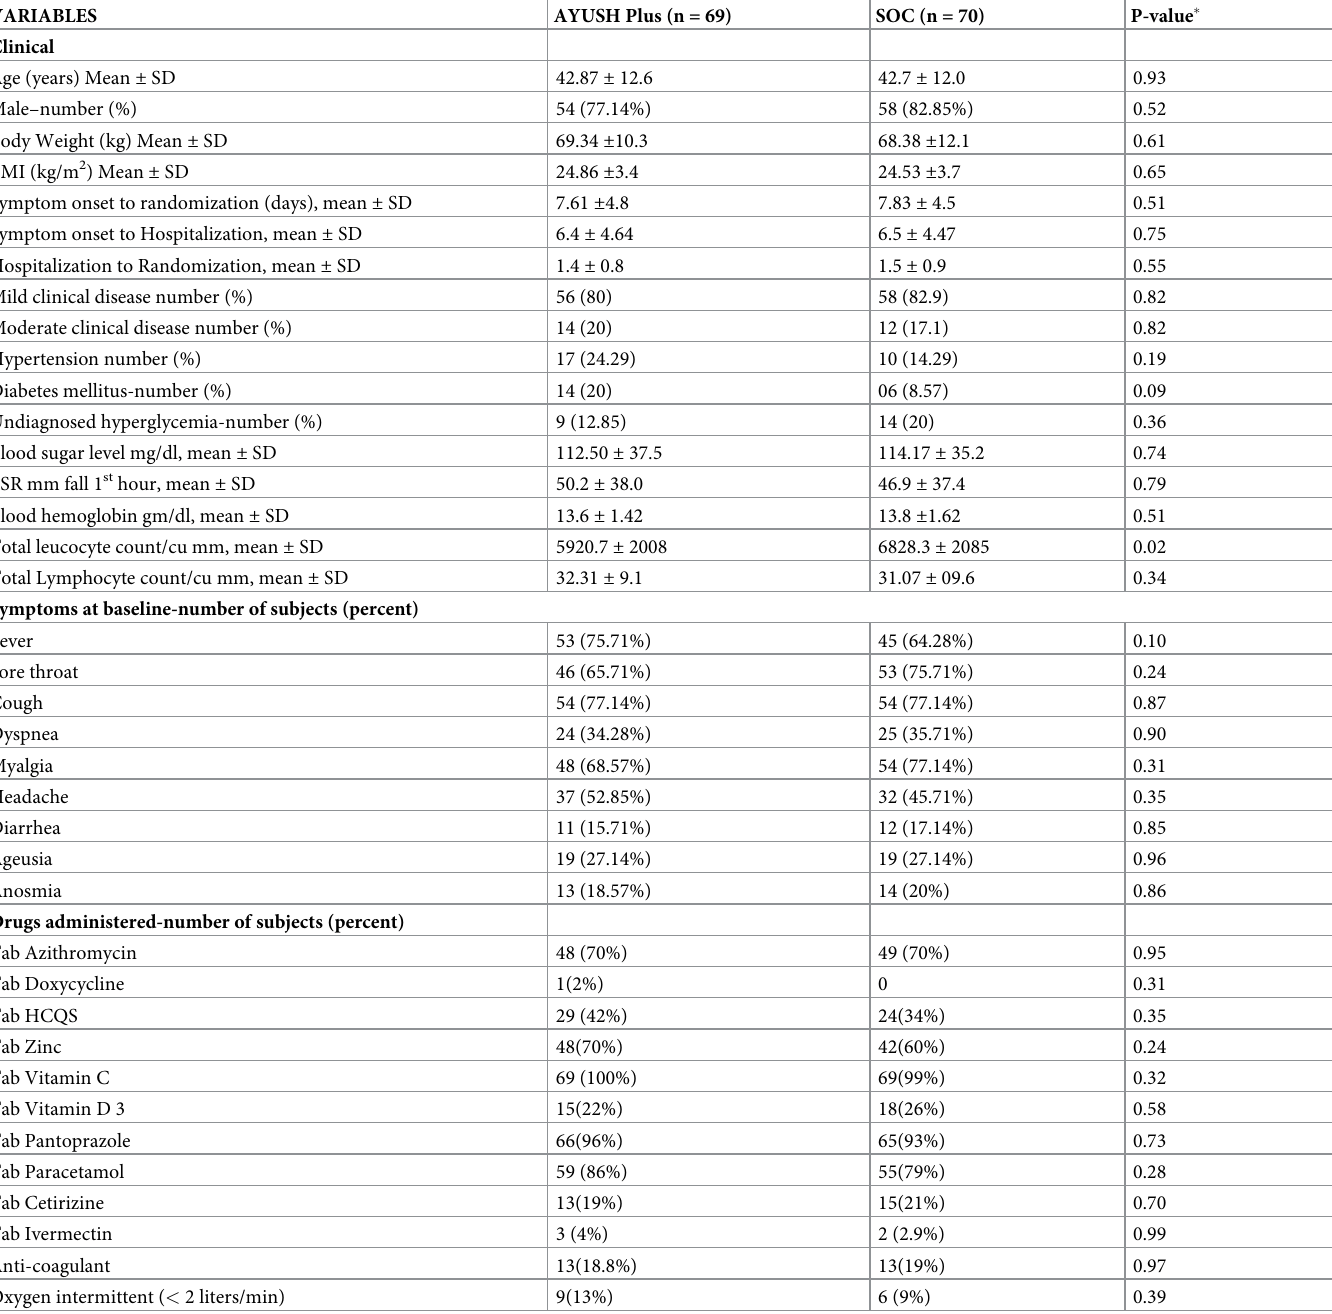
Table 1. Randomization baseline data on demographic, clinical, COVID related timelines, laboratory variables, and Standard of Care (SOC) drugs in the study